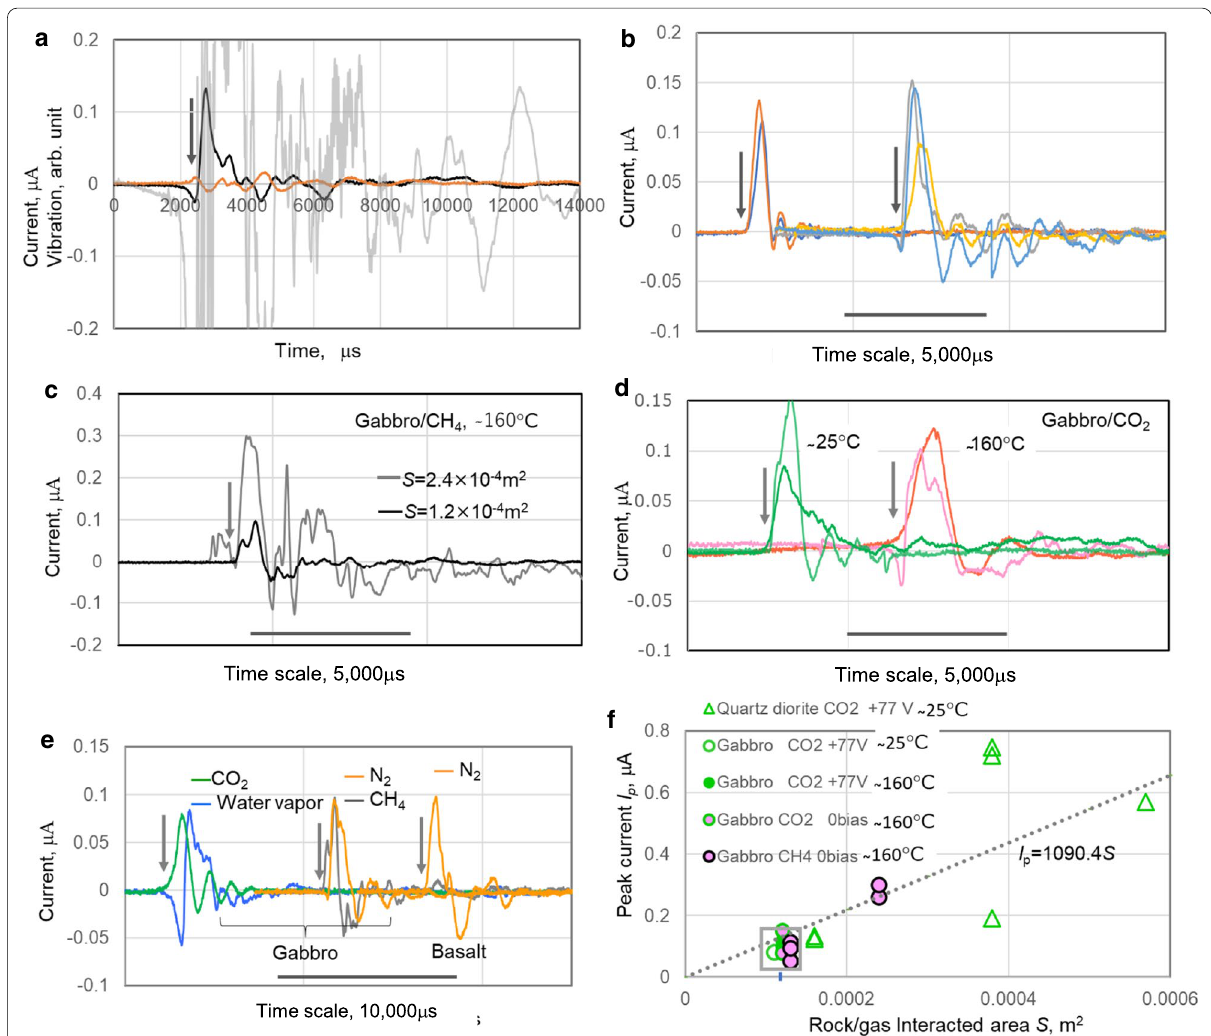
Fig. 2 a Current signals for combination of quartz diorite/CO 2 at ~ 25 °C with electrode bias of 77 V and S 1.6 10 –4 m 2 , where black curve is + = × the signal at the gas current electrodes, orange curve is the signal at the reference electrode, and light grey curve is the vibration signal; b electric currents for combination of quartz diorite/CO 2 at ~ 25 °C with electrode bias of 77 V (left) and electric currents for combination of gabbro/CO 2 ± at ~ 160 °C with electrode bias of 77 V and without bias (0 V) (right) (in all tests, S 1.2 10 –4 m 2 ), where blue curves are at electrode bias of ± = × 77 V, orange ones are at 77 V and grey one is at 0 V; c electric currents for combination of gabbro/CH 4 at ~ 160 °C without electrode bias at − + S 1.2 10 –4 m 2 and S 2.4 10 –4 m 2 ; d electric currents for combination of gabbro/CO 2 at ~ 25 °C and ~ 160 °C (two signals for each temperature = × = × overlap because two tests were performed at each temperature to check the reproducibility) and e electric signals for combination of gabbro/CO 2 , water vapour, N 2 , and CH 4 at ~ 160 °C and combination of basalt/N 2 at ~ 160 °C. Arrows in a – e show the final rupture point when the gas started to flow in the crack gap. f Relationship between the peak current I p and rock/gas interaction area S for the various test conditions listed in the plot legend. The data for quartz diorite/CO 2 for 77 V and ~ 25 °C were taken from one author’s previous work (Enomoto et al. 2017). The dotted line in f + is an approximated relation: I p (μA) 1069 S (m 2 ), where the coefficient of determination is R 2 = × =